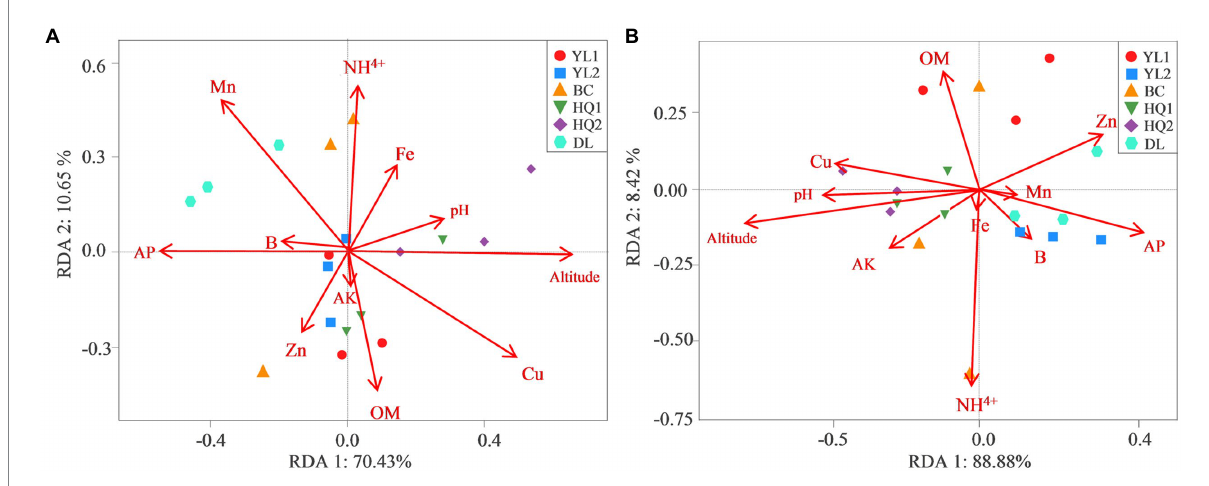
FIGURE 5 RDA measures the linkage between bacterial (A) and fungal (B) community composition, soil physicochemical properties, and